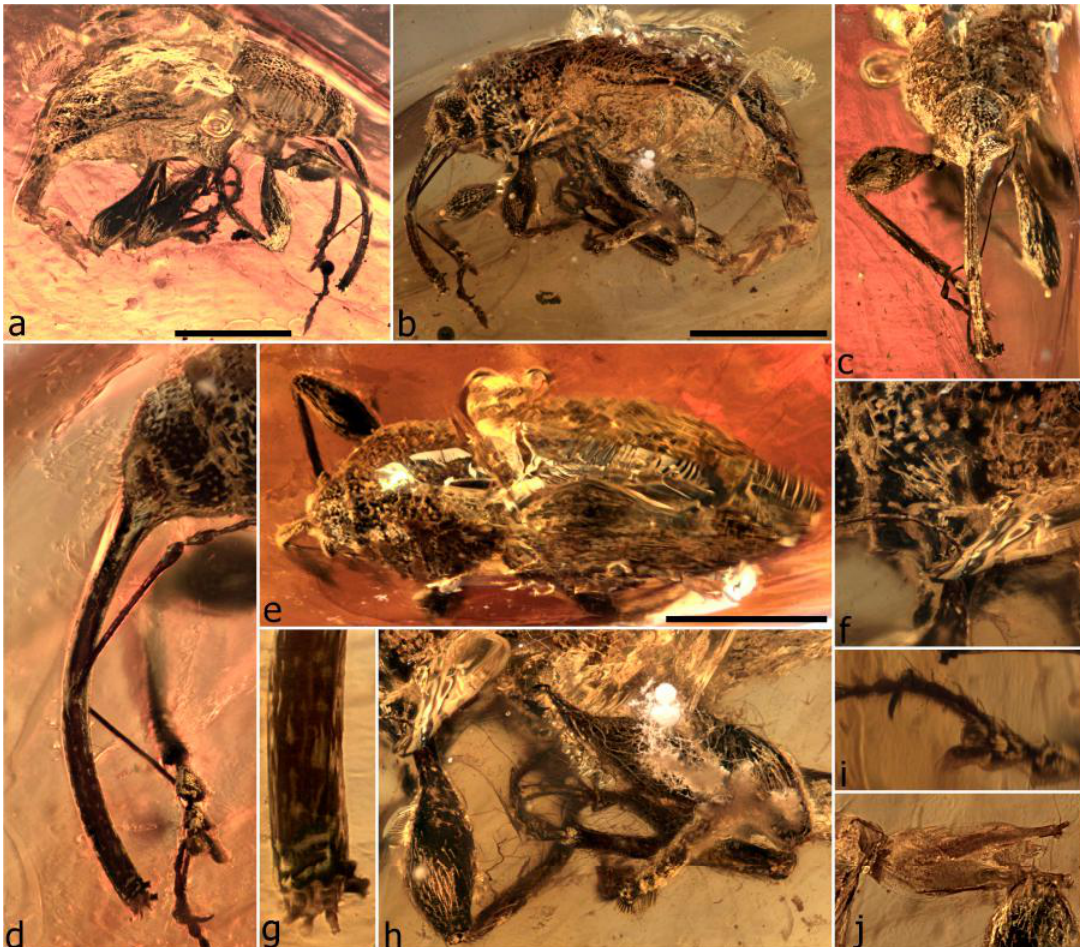
Figure 49. Debbia gracilirostris sp. n., holotype. Habitus, right lateral ( a ); habitus, left lateral ( b ); head, frontal ( c ); head and left protarsus, left lateral ( d ); habitus, dorsal ( e ); prothorax, showing notosternal suture, left lateral ( f ); apex of rostrum showing mandibles and maxillary palps, left lateral ( g ); legs, left lateral ( h ); right protarsus ( i ); ovipositor ( j ). Scale bars: 1.0 mm